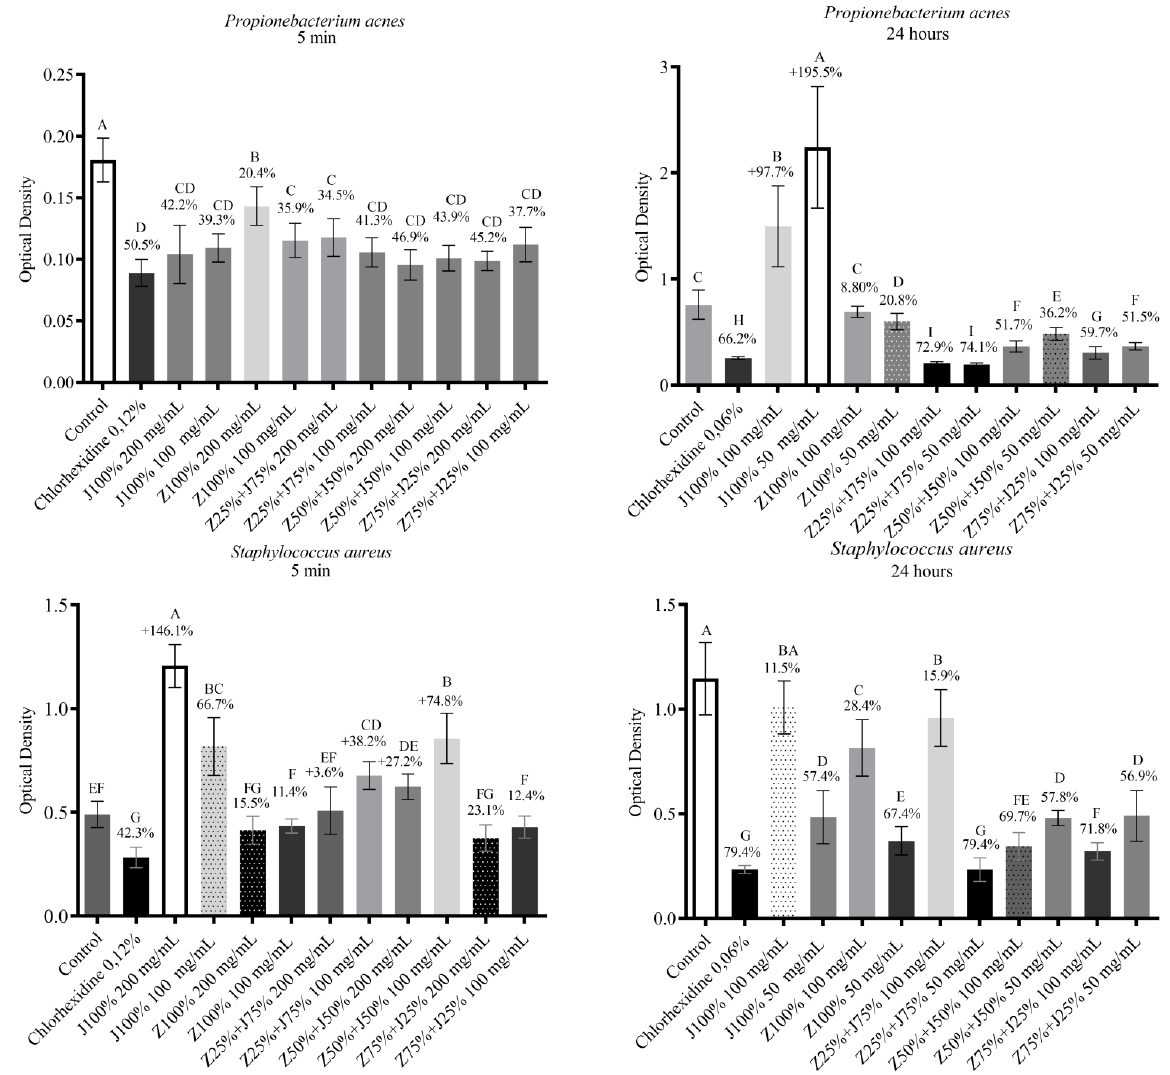
Figure 1. Anti-biofilm action of association by Z. officinale and J. regia extracts on monotypic biofilm of P. acnes and S.